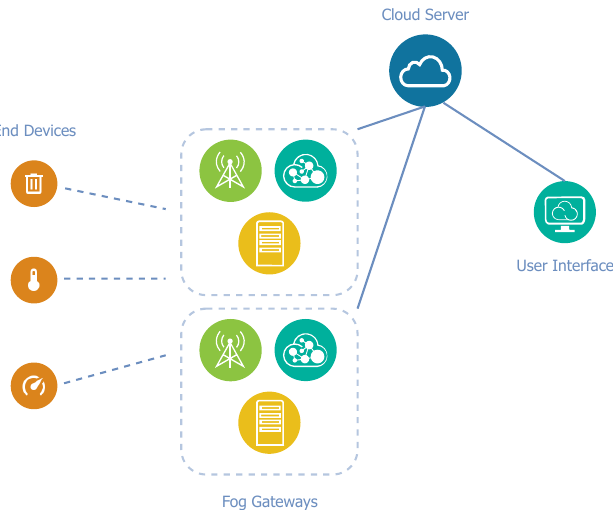
Figure 3. Diagram of network architecture